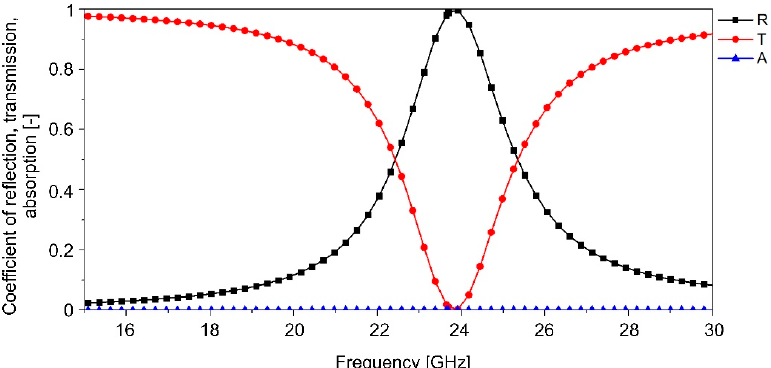
Figure 5. Coefficients of reflection (R), transmission (T), and absorption (A) of the electromagnetic radiation of the metasurface as a function of frequency.